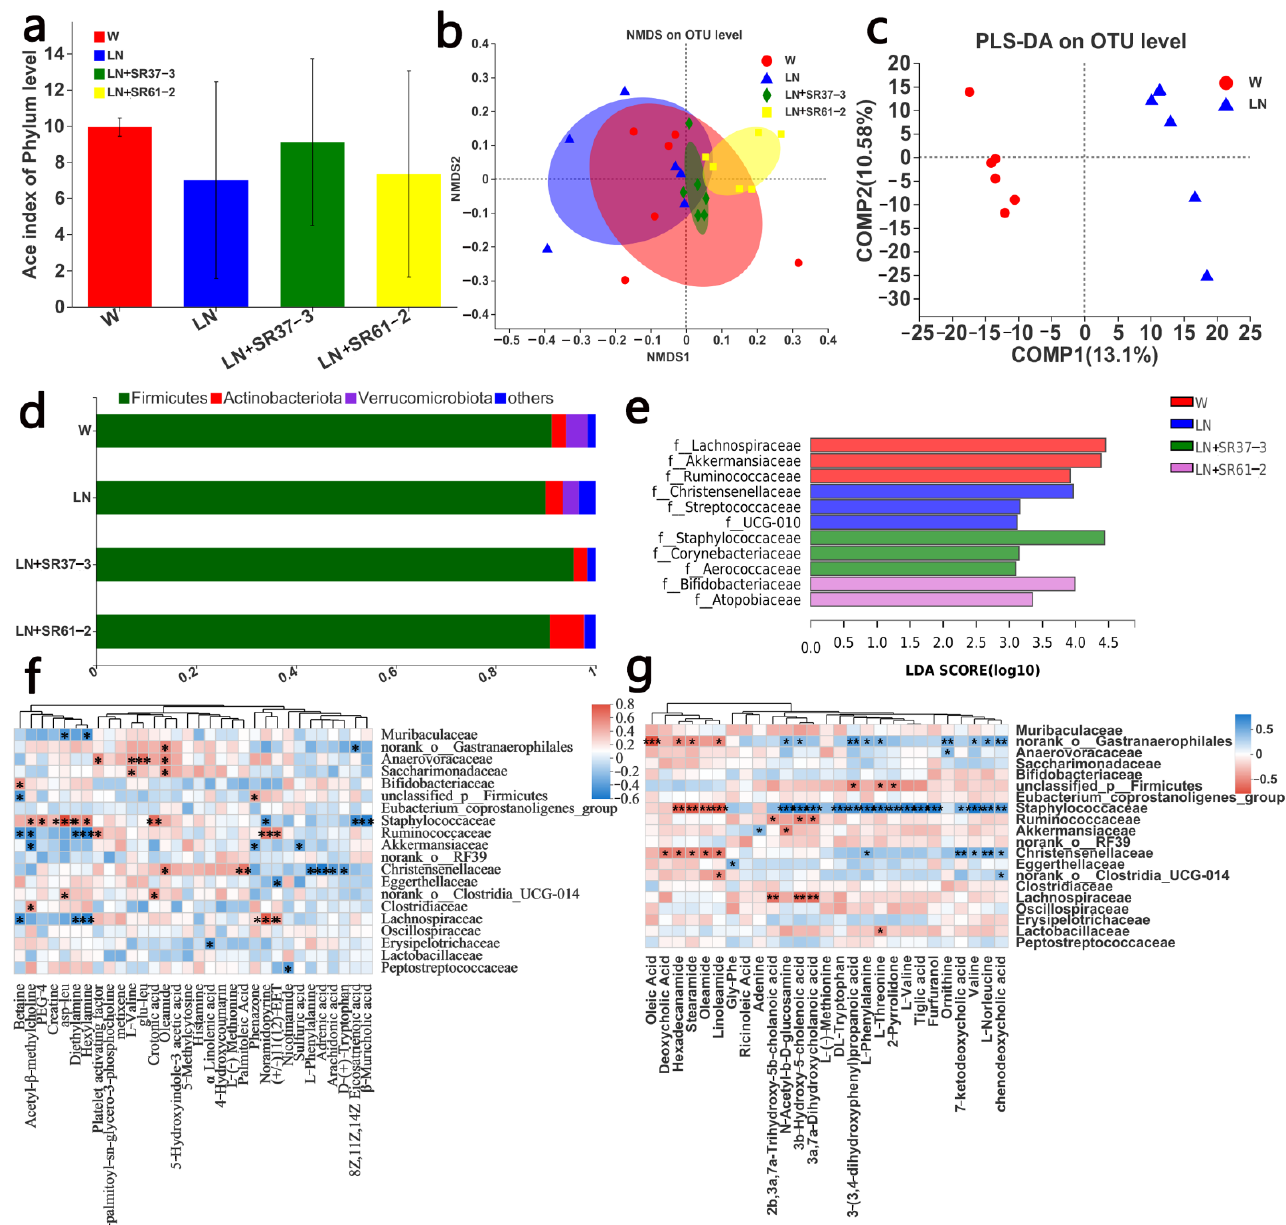
Figure 3. PFM regulated the bacterial community of the cecum microbiota. ( a ) ACE Index; ( b ) NMDS; ( c ) PLS ‐ DA on the OTU level between W and LN; ( d ) relative abundance richness at phyla level; and ( e ) LEFSE on family level. ( f ) Correlation heatmap between intestinal microorganisms and environmental factors (serum differential metabolites), * p < 0.05, ** p < 0.01, *** p < 0.001. ( g ) Correlation heatmap between intestinal microorganisms and environmental factors (differential metabolites of cecal contents), * p < 0.05, ** p < 0.01, *** p < 0.001. cont W: animals not treated with L ‐ NAME receiving standard chow; cont LN: L ‐ NAME treated rats receiving standard chow; LN + SR37 ‐ 3: L ‐ NAME treated rats receiving PFM ‐ SR37 ‐ 3; LN + SR61 ‐ 2: L ‐ NAME treated rats receiving PFM ‐ SR61 ‐ 2.